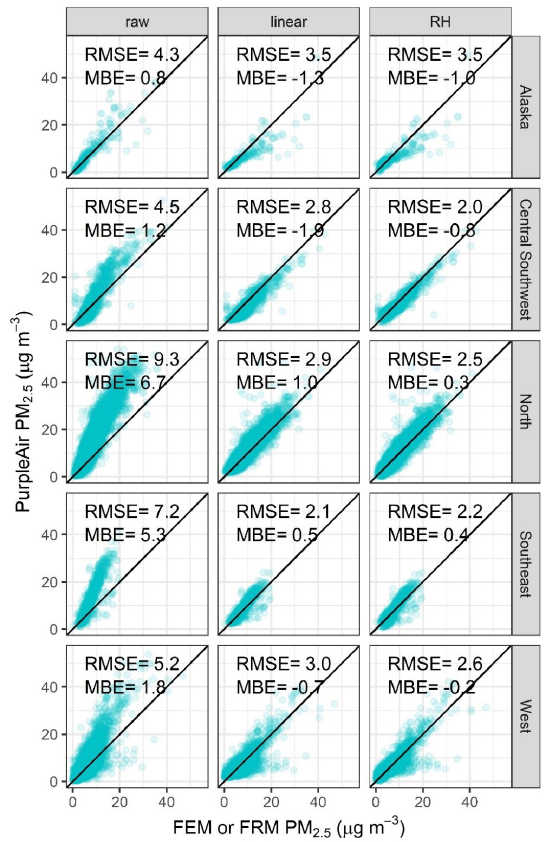
Figure 6. Scatterplot of the daily FEM or FRM PM 2 . 5 data with the PurpleAir data by US region (see Fig. 2) prior to any correction, after applying a linear correction, and after applying the final cor- rection including RH. Data were corrected using the models built for the full dataset.